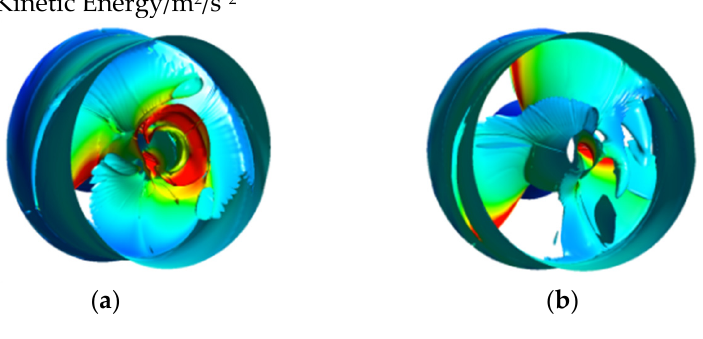
Figure 7. Turbulent kinetic energy of the runner: ( a ) Operation condition 1; ( b ) operation condition 2; ( c ) operation condition 3.